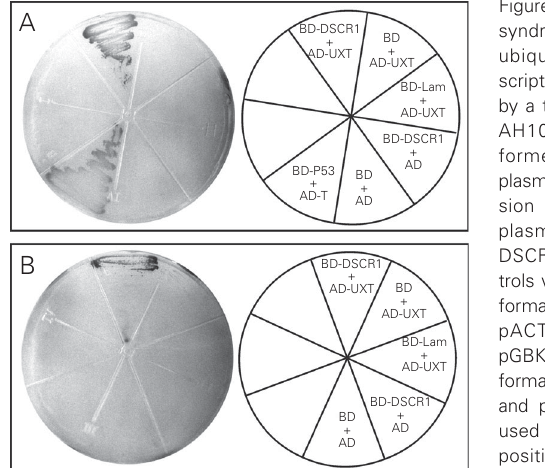
presses murine p53 fused with the GAL 4 DNA BD and pGADT7-T, expressing the SV40 screen). Transformants were streaked on plates with SD/-Leu/-Trp/-His/-Ade medium containing X- α -GAL. Reconstitution of GAL 4 activity restored the ability to grow under